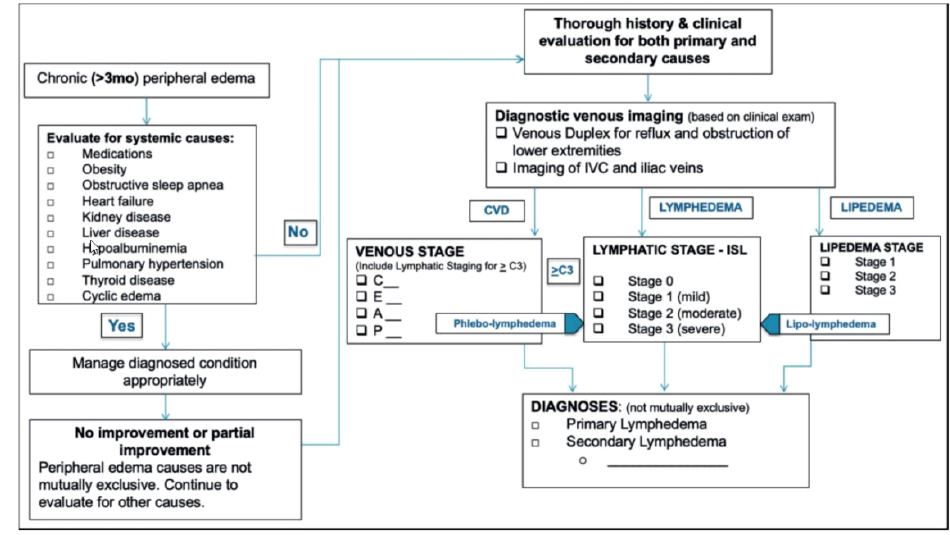
Figure 2. The diagnostic algorithm proposed for the differentiation of chronic lower extremity swelling [19]. IVC, inferior vena cava; C, CEAP classification; CVD, chronic venous disease. From [19]. Reprinted by Permission of SAGE Publications.